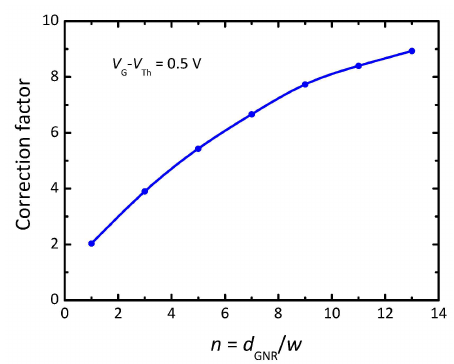
Figure 8. Correction factor for the dielectric constants of the top-gate dielectric and the GNR that reproduces the effect of the interribbon gate. Note that the correction factor has been determined for one single effective gate voltage (0.5 V).